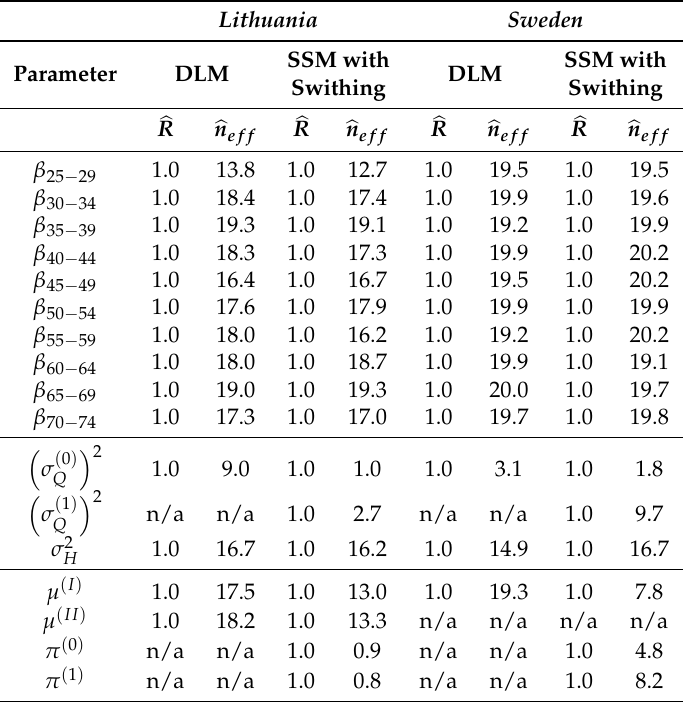
Table 2. Estimates of convergence statistics (cid:98) R and effective sample size statistics n ef f (presented in thousands) for DLM and SSM with switching model parameters, calculated for five MCMC chains of 4000 iterations after warm-up (total of 20 thousand iterations).